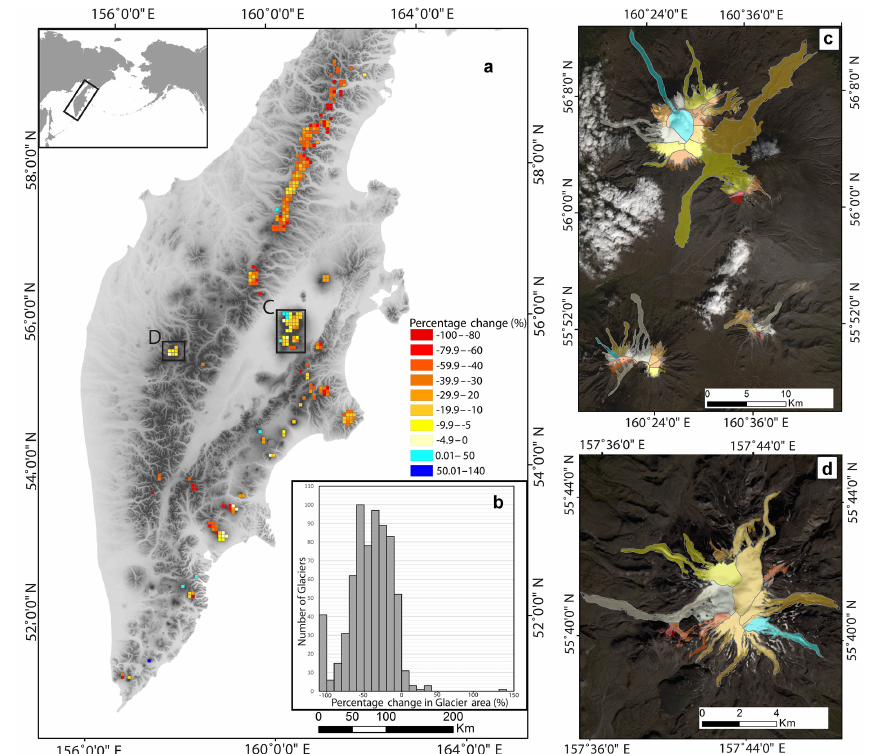
Figure 4. Percentage change in glacier surface area across the Kamchatka Peninsula between 2000 and 2014. (a) Mean values shown for 5 × 5km grid cells. (b) Values for individual glaciers shown as a frequency distribution. (c) Values for individual glaciers in the Klyuchevskaya volcanic group. (d) Values for individual glaciers on the slopes of Ichinsky Volcano. In both (c) and (d) , the colour scheme from (a) is used.